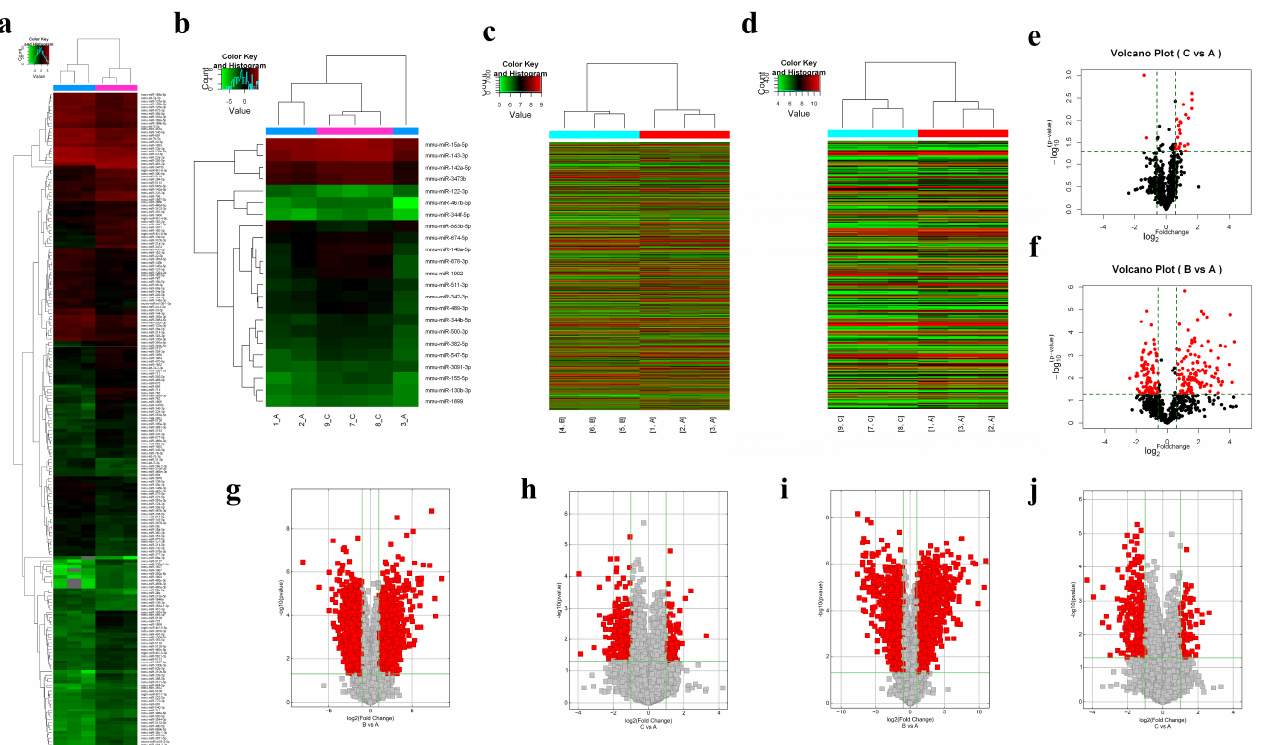
Figure 2. Heatmap and volcano plots showing lncRNA, miRNA, and mRNA expressions in the ear tissue homogenate on the remission and elicitation phase of the AD recurrence model. ( a , b ) Hierarchical clustering for differentially expressed miRNAs. ( c , d ) Hierarchical clustering for differentially expressed lncRNAs. The color scale shown at the top illustrates the relative expression level of a miRNA and lncRNAs in a specific slide: red, high relative expression; green, low relative expression. ( e , f ) Volcano plot of normalized expression levels for differentially expressed miRNAs. ( g , h ) Volcano plot of normalized expression levels for differentially expressed lncRNAs. ( i , j ) Volcano plot of normalized expression levels for differentially expressed mRNA. The vertical lines correspond to 1.5-fold upregulation and downregulation for miRNAs, 2-fold upregulation and downregulation for miRNAs, and the horizontal line represents a p value of 0.05. The red point in the plot represents the differentially expressed miRNAs with statistical significance (A: control; B: elicitation phase; C: remission).